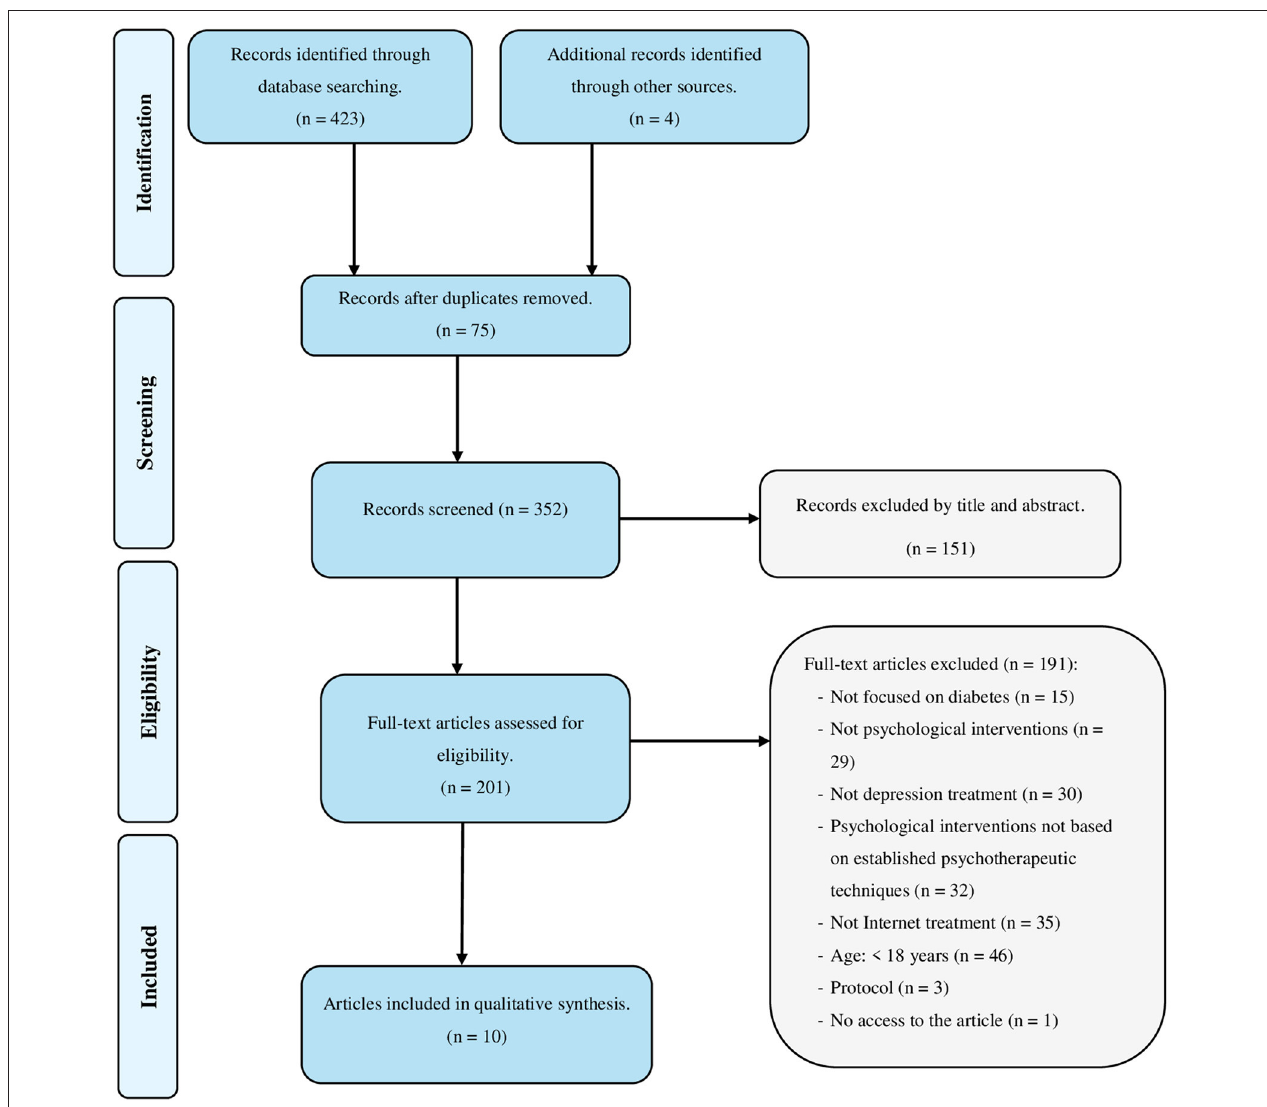
FIGURE 1 | Flow diagram based on PRISMA